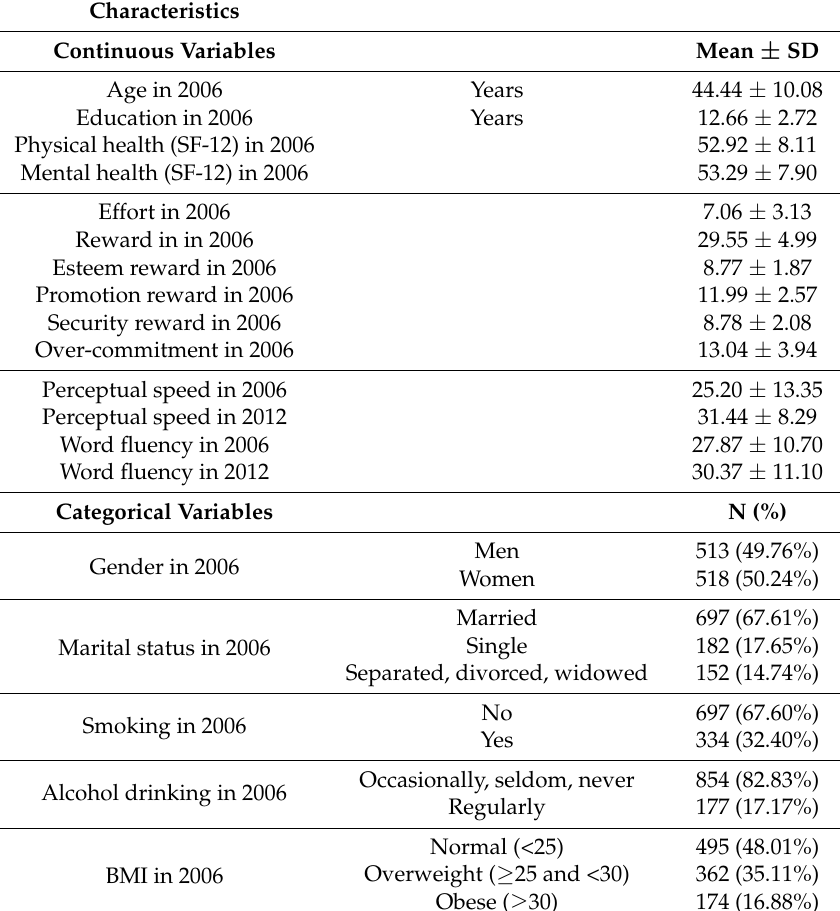
Table 1. Characteristics of study subjects ( n =